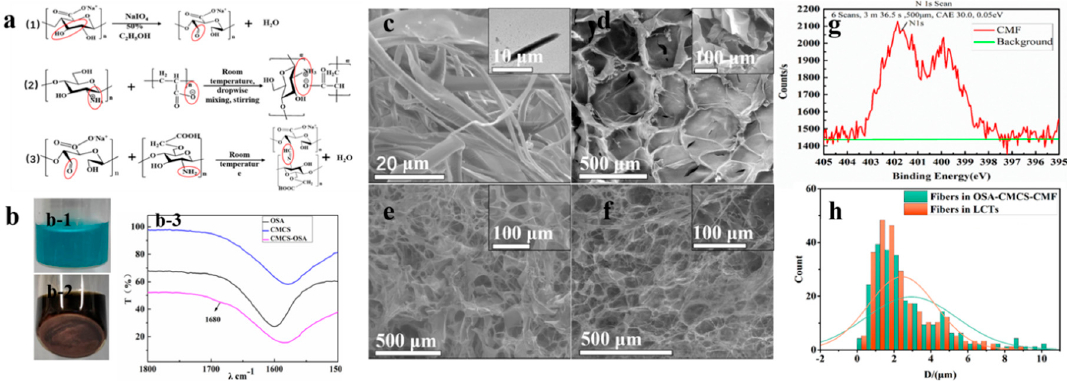
Figure 2. ( a ) Reactions and principles designed in the article: (1) Schiff base reaction equation of OSA and CMCS; (2) schematic diagram of prepared microfiber (CMF) preparation via electrostatic self-assembly of CM and PAA; (3) sodium alginate oxidation. ( b ) Identification of chemical groups: ( b-1 ) Fehling’s solution and oxidized sodium alginate mixture; ( b-2 ) solution of b1 was heated for 40 min, ( b-3 ) Fourier transform infrared spectroscopy of OSA, CMCS, and OSA-CMCS. Environmental scanning electron microscopy (ESEM) images of ( c ) prepared microfiber (CMF), with TEM of a single CMF (inset, upper right corner), ( d ) OSA-CMCS topographic structure, ( e ) OSA-CMCS-CMF topographic structure, and ( f ) connective tissue under the skin of rat backs. ( g ) X-ray photoelectron spectroscopy (XPS) element analysis. ( h ) Normal distribution of fibers in the loose connective tissue of rat backs (LCT) and of CMFs in OSA-CMCS-CMF. 2.2.2. Preparation of Fibers A 0.137 M adipic acid solution was used as the solvent to prepare a 0.01% CM solution, and distilled water was used as the solvent to prepare a 1% PAA solution, resulting in a viscous liquid with a content of 30% and an average molecular weight of 3000 M. The CM solution was slowly added dropwise to the PAA solution until a final volume ratio of 1:3 was reached; the solution was then left to stand at 25 °C for 1 h. Upon completion of the reaction, the solution was frozen at − 80 °C, thawed, centrifuged, and freeze-dried to obtain the CMFs. The reaction is shown in Figure 2a (step 2). 2.2.3. Preparation of Basic Hydrogel Using 0.9% NaCl as the solvent, a 10% OSA solution and 2.5% CMCS solution were prepared, which were subsequently mixed to generate OSA-CMCS solutions with different volume ratios. The gelation reaction temperature was 37 °C. A stopwatch was activated to begin timing when the OSA and CMCS solutions were evenly mixed. The state of the hydrogel was determined by repeatedly inverting the sample bottle. When the gel did not reflux upon vial inversion, this indicated that the hydrogel changed from a sol state to a gel state, and the time was immediately recorded from the stopwatch as the gelation time. The reaction is shown in Figure 2a (step 3). 2.2.4. Preparation of Hierarchical Fiber Hydrogel A 0.9% NaCl solution was used to prepare a 10% OSA solution and CMCS-CMF solutions containing various proportions of CMF ranging from 0–0.5%. The mixture was reacted at a volume ratio of 1:2 to obtain OSA-CMCS-CMF. The gelation reaction temperature was 37 °C. A stopwatch was used to record the gelation time from when the OSA and CMCS-CMF solutions were evenly mixed. The gelation time was subsequently obtained using the procedure outlined in Section 2.2.3. 2.2.5. Fourier Transform Infrared Spectroscopy Equal volumes of CMCS, OSA, and OSA-CMCS solutions were separately added to compressed KBr. After drying in an oven at 37 °C for 24 h, infrared spectroscopy was performed on the above